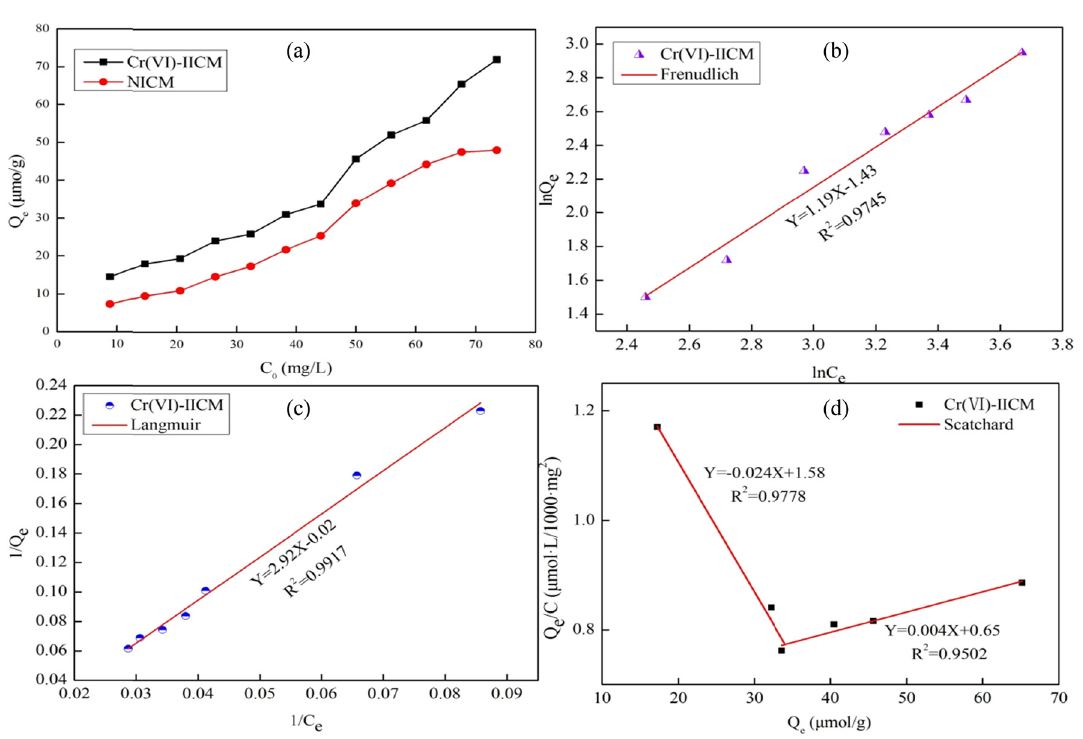
Figure 4: Adsorption isotherms of IICM ( a ) , Freundlich fi tting curve ( b ) , Langmuir fi tting curve ( c ) , Scatchard fi tting curve ( d ) .